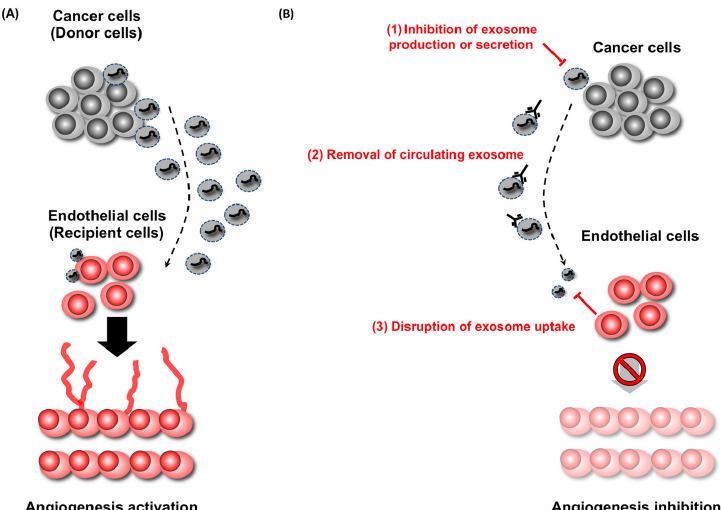
Figure 2. Therapeutic strategies against cancer ‐ derived EVs. EVs are secreted from cancer cells and delivered to recipient cells, modulating the phenotype of the recipient cells. For instance, EVs from cancer cells are delivered to endothelial cells, which enhance angiogenesis ( A ). In this case, there are three therapeutic applications ( B ): (1) inhibition of EVs production from cancer cells; (2) elimination of circulating EVs from cancer cells; and disruption of EVs uptake by recipient cells (3). These therapeutic applications will prevent the delivery of EVs from cancer cells to endothelial cells, leading to the suppression of development of cancer